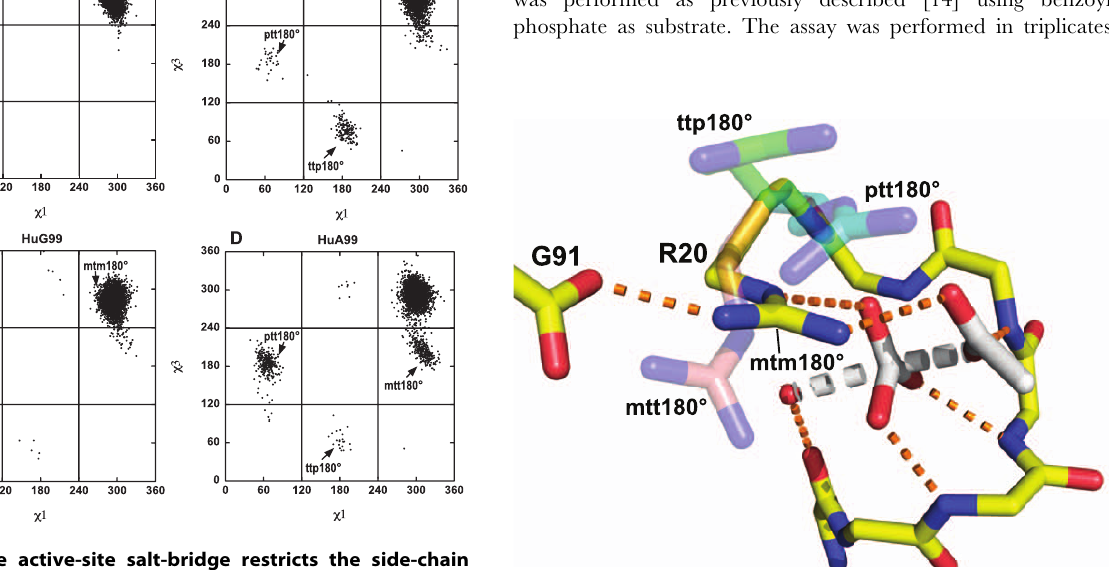
Figure 5. The active-site arginine residue of acylphosphatase adopts the mtm180 6 rotamer conformation for catalysis. The model of enzyme-transition-state complex was derived from the model of enzyme-substrate complex [14] by orientating the phosphorus atom towards the water molecule. Hydrogen bonds and salt-bridges are denoted by orange dotted lines. According to the proposed model, the guanido group of Arg-20 can form charge-charge interactions to stabilize the transition-state when the residue adopts the mtm180 u rotamer conformation. For the mtt180 u , ttp180 u , and ptt180 u rotamer conformations, the guanido group is too far away to form any favorable interactions with the transition state.